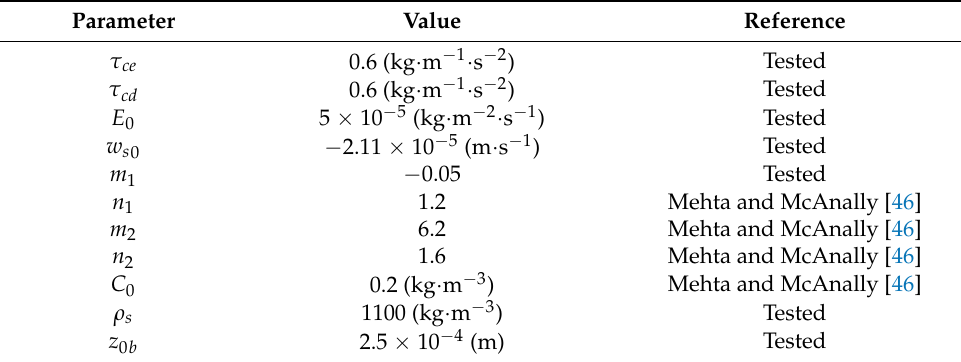
Table 1. Parameters used in the suspended sediment transport